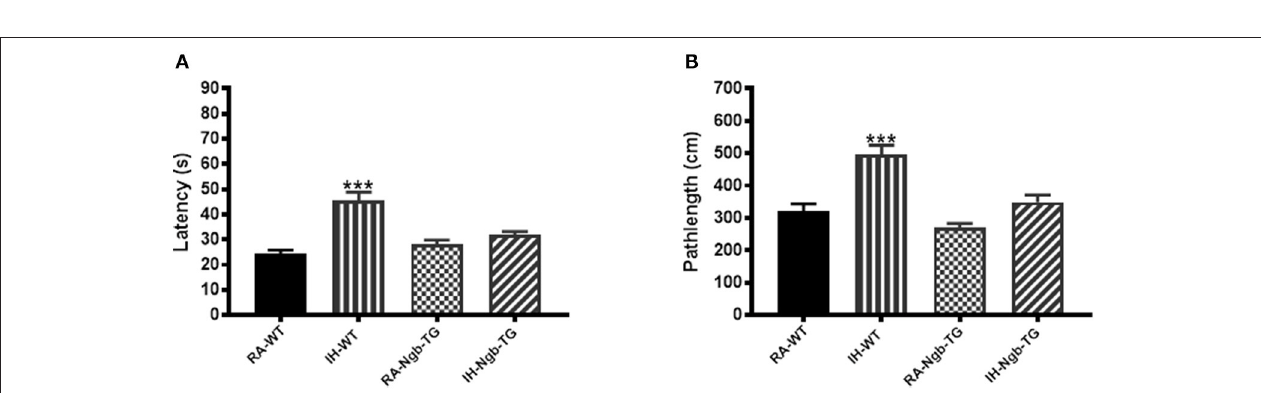
FIGURE 4 | Ngb-TG mice exposed to IH do not exhibit deficits in spatial task retention in the Morris water maze. (A) Mean latencies (s) and (B) pathlength (cm) to locate the submerged platform location during retention trials in WT and Ngb-TG either exposed to intermittent hypoxia (IH) or maintained in room air (RA) in the Morris water maze. ( n = 14/experimental group; *** P < 0.0001 vs.